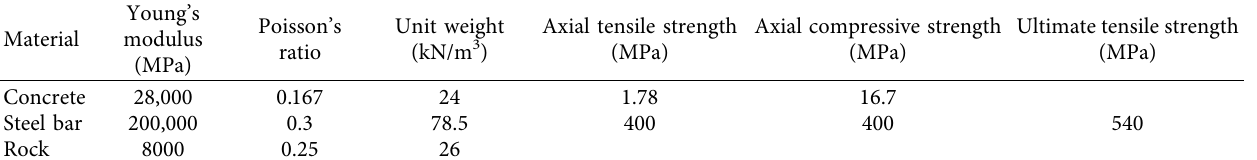
Figure 7: Geometry and FE mesh of Jx HP. (a) Global model. (b) Details of the powerhouse. (c) Substructure. (d) RCF-SW. (e) Re- inforcement grids. Table 3: Mechanical properties of